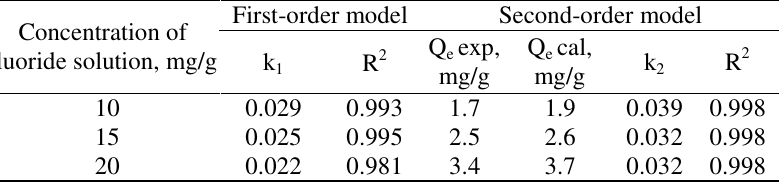
Table 3. Rate constants of kinetic models for the adsorption of fluoride on CCS.